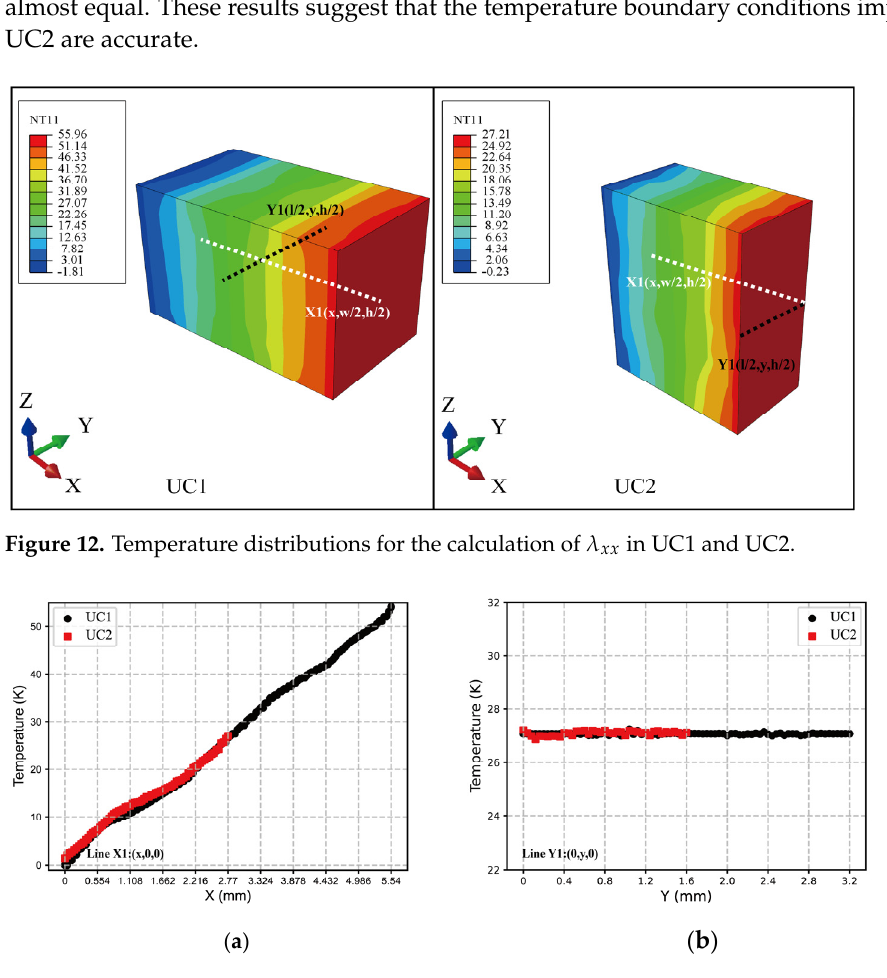
Figure 13. Temperature on lines ( a ) X1; ( b ) Y1.